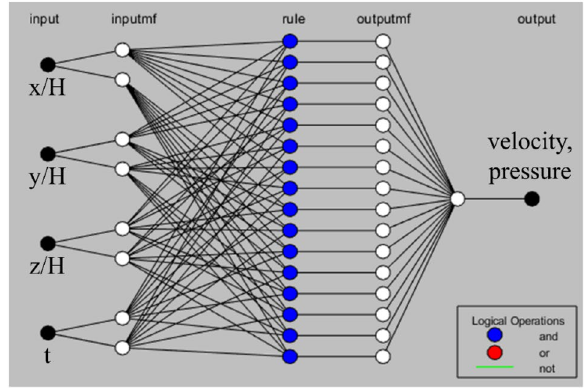
Figure 3. ANFIS structure with a four-input first-order Sugeno fuzzy model in MATLAB 2017a. 4 inputs of coordinates system, and time t were applied and the output was the instantaneous 3D velocity components and